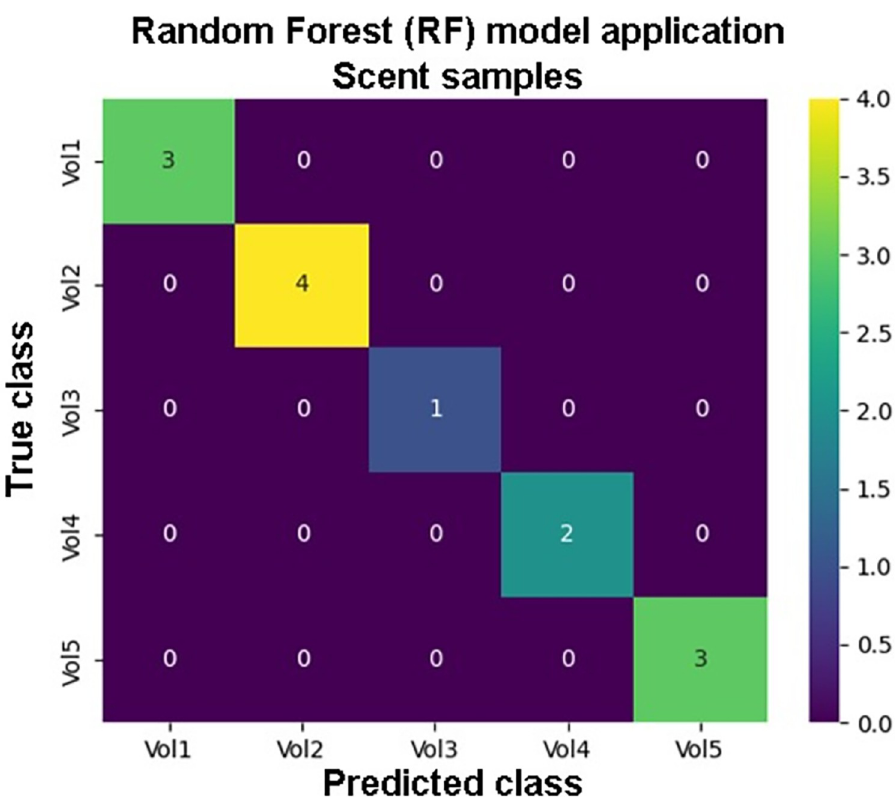
Fig 6. Confusion matrix for the best performing RF model. The train/test split ratio for the model training was 75%/25%.